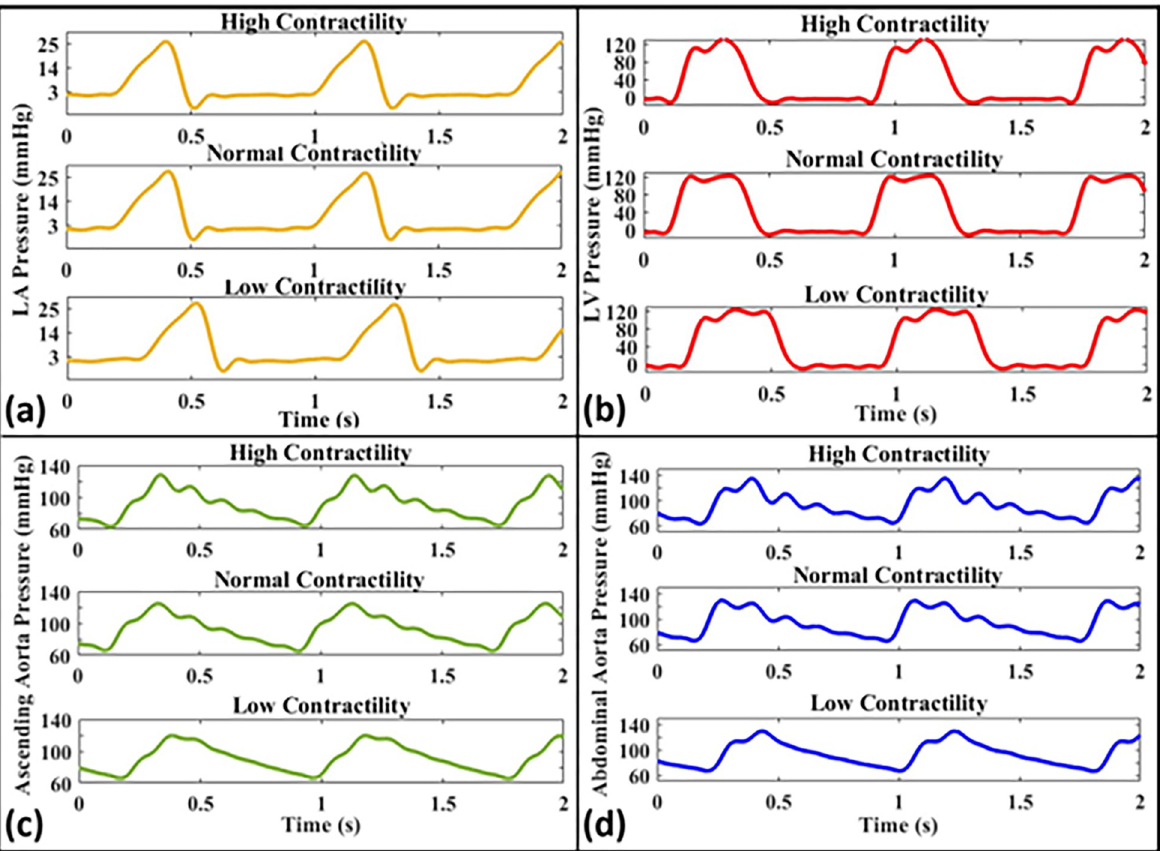
Fig 9. Pressure waveforms for different contractility conditions including high (LV -dp/dt mmHg/s), and low contractility (LV -dp/dt Max = 937.4 mmHg/s) at (a) the left atrium, (b) the left ventricle, (c) the ascending aorta, and (d) the abdominal aorta (Aorta-4, HR = 75 bpm, CO = 5